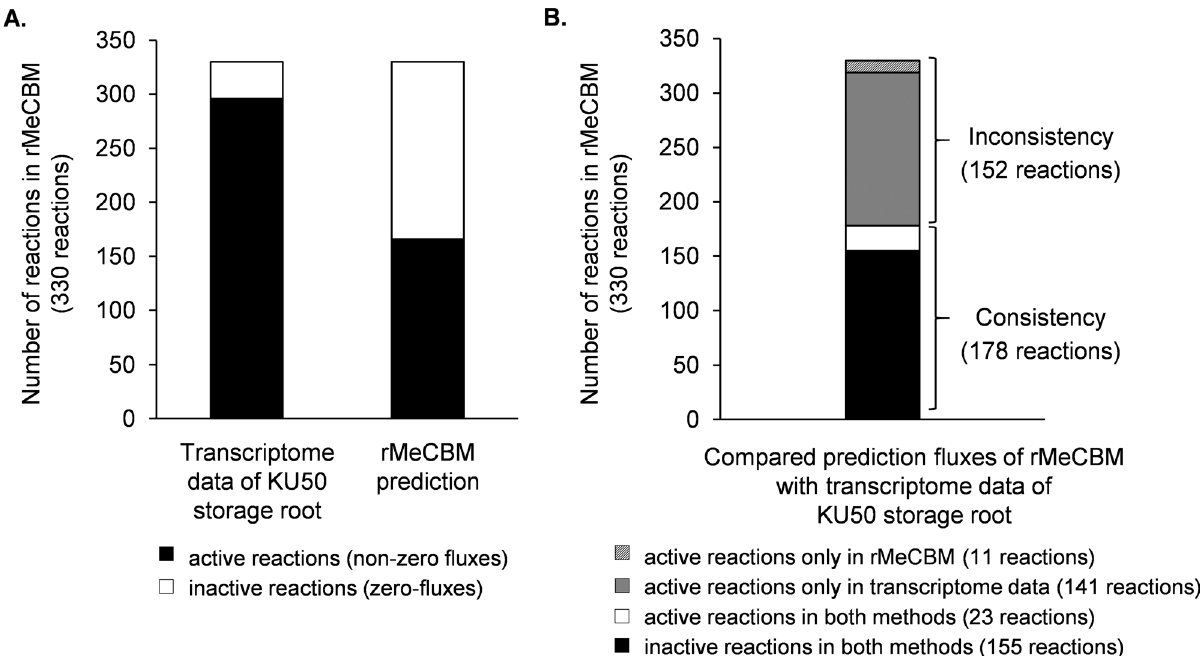
Figure 2. Comparison of 330 biochemical reactions from the rMeCBM model to transcriptome data of developing storage roots of cultivar KU50 at five months old under field conditions, from Wang et al. 32 . ( A ) The number of active and inactive reactions based on transcriptome data of KU50 storage roots and flux prediction from the rMeCBM model. ( B ) Comparison of reactions inferred from transcriptome data and flux prediction (see more details in Supplementary Data